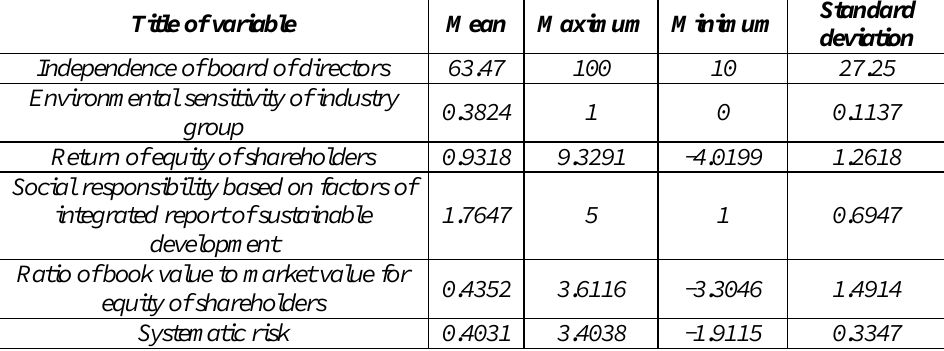
Table 2. Descriptive statistics of research